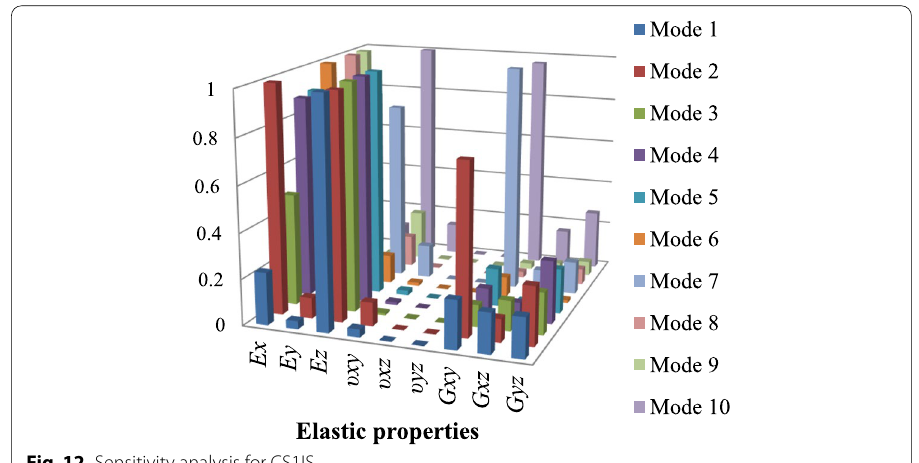
Fig. 12 Sensitivity analysis for